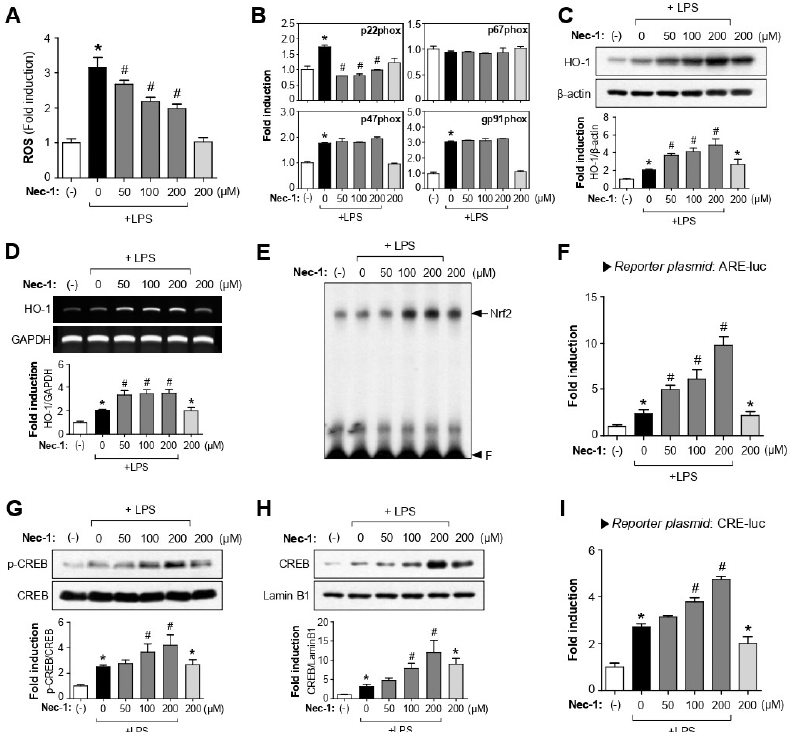
Figure 4. Nec-1 reduced ROS production via suppression of p22phox NADPH oxidase subunit and upregulation of Nrf2/ARE and PKA/CREB signaling. ( A ) BV2 cells were treated with Nec-1 1 h prior to LPS stimulation for 8.5 h. Intracellular ROS level was measured using the DCF-DA assay. ( B ) Quantitative real-time PCR to assess mRNA expression of NADPH oxidase subunits (p22phox, p47phox, p67phox, and gp91phox) in BV2 cells. ( C,D ) Western blot and RT-PCR analysis to determine the effect of Nec-1 on the protein and mRNA expression of HO-1. BV2 cells were treated with Nec-1 for 1 h, followed by LPS (100 ng/mL) for 6 h. ( E ) EMSA for Nrf2 DNA binding activity. BV2 cells pretreated with Nec-1 and incubated with LPS (100 ng/mL) for 1 h. ( F ) Transient transfection analysis of ARE-luc reporter gene activity. ( G,H ) Western blot analysis for p-CREB and total CREB was performed using cell lysates and nuclear extracts from BV2 cells, respectively. ( I ) Transient transfection analysis of CRE-luc reporter gene activity. Data are shown as the mean ± SEM of three independent experiments. * p < 0.05 vs. control; # p < 0.05 vs. LPS-treated samples. 3.6. Nec-1 and Nec-1s Inhibited Microglial Activation and Proinflammatory Gene Expression in the Brains of LPS-Injected Mice To confirm the anti-inflammatory effect of Nec-1 and Nec-1s in vivo, mice were ad- ministered Nec-1 or Nec-1s before LPS injection. After 24 h, the mice were sacrificed, and microglial activation was assessed by staining their brain tissue with an antibody against Iba-1, a marker of microglial activation. LPS treatment increased the number of Iba-1-pos- itive activated microglial cells, whereas Nec-1or Nec-1s treatment decreased the number of activated microglia cells in the dentate gyrus (DG), cerebral cortex, and substantia nigra